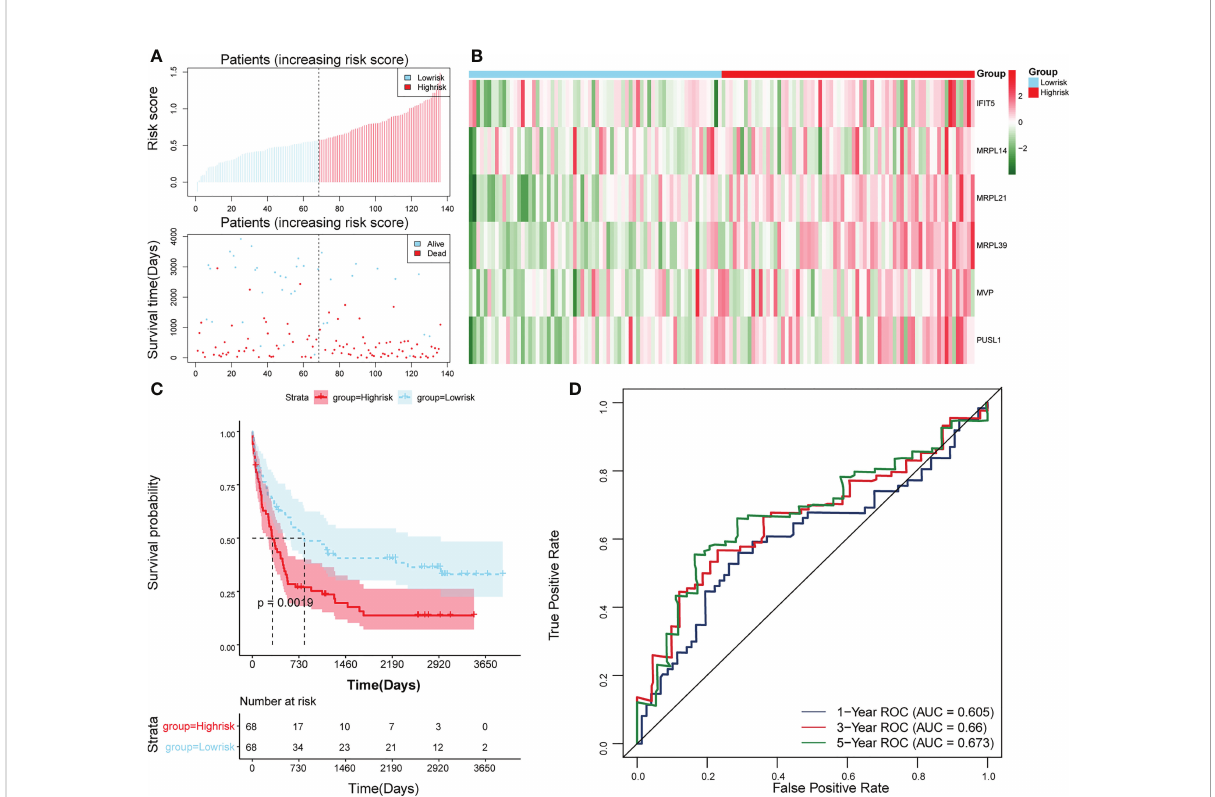
FIGURE 4 Validation of the risk model in GSE37642. (A) Distributions of risk scores and survival states between high- and low-risk groups in GSE37642. (B) Heatmap of 6 biomarkers in high- and low-risk groups in GSE37642. (C) The Kaplan-Meier survival curve for the high-and low-risk groups in GSE37642. (D) ROC curves at 1-, 3-, and 5 years in